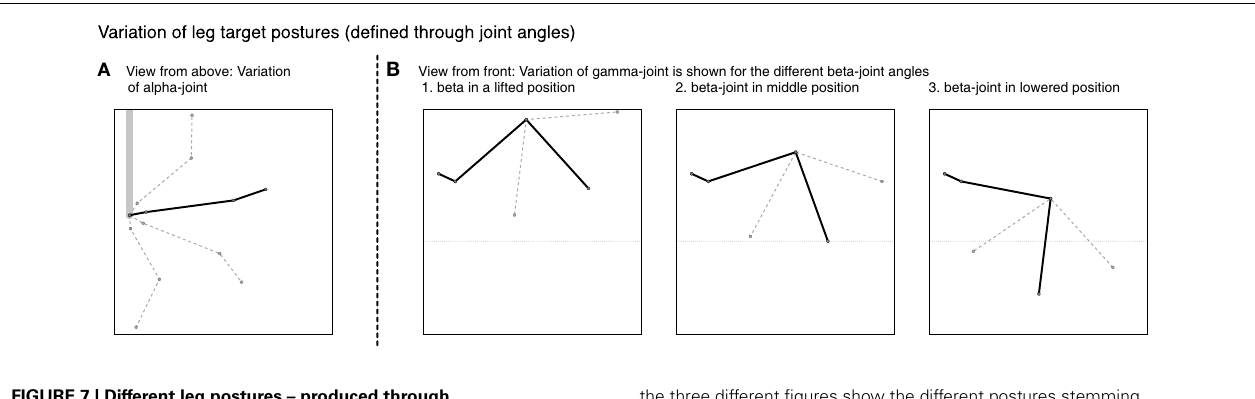
FIGURE 7 | Different leg postures – produced through variation of joint angles. In (A) the four different alpha joint angles used for the definition of the postures are shown. In (B)